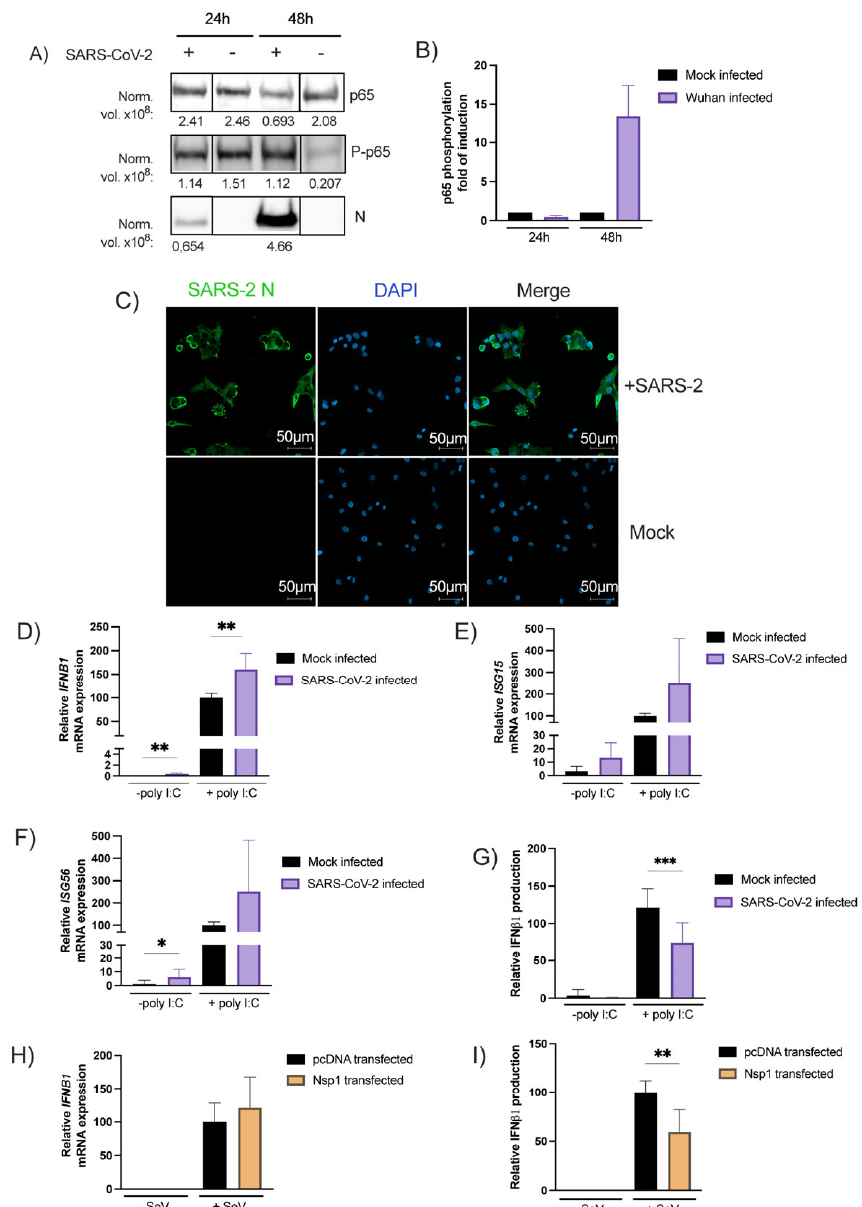
Figure 3. The NF- κ B p65 subunit expression and phosphorylation following infection with the SARS-CoV-2 ( A , B ). A549-hACE2 cells in 6-well plate infected as described in the method section. Then, harvest RIPA buffer with Halt Phosphatase Inhibitor Cocktail detected by Western Blot with anti-p65, anti-P-p65 or anti-SARS-CoV-2-N and Stain-Free Imaging Technology ® as loading control (Supplementary Figure S1) and expressed as normalized levels (Norm. vol. × 10 8 ) below the blot. Then, NF- κ B p65 phosphorylation is normalized with p65 subunit expression and expressed as fold of induction relative to the mock-infected control (mean ± SD, n = 2 replicates/condition) ( B ). SARS-CoV-2 Nucleocapsid staining on A549-hACE2 infected cells. Forty-eight hours post-infection cells were fixed and stained as described in the materials and methods section. This staining was performed a least three times and a representative picture was shown. ( C ). Effect of SARS-CoV-2 infection on poly(I:C) IFNB1 mRNA expression ( D ), ISG15 mRNA ( E ) or ISG56 mRNA expression ( F ), induced IFN β 1 production ( G ). Twenty-four hours post-seeding, A549-hACE2 cells were infected with SARS-CoV-2 as described in the materials and methods section. Thirty-two hours post-infection, SARS-CoV-2 and mock-infected cells were stimulated with poly(I:C) and RNA extracted and analyzed with RT-qPCR while IFN β 1 was measured in the supernatant by ELISA. Effect of Nsp1 on